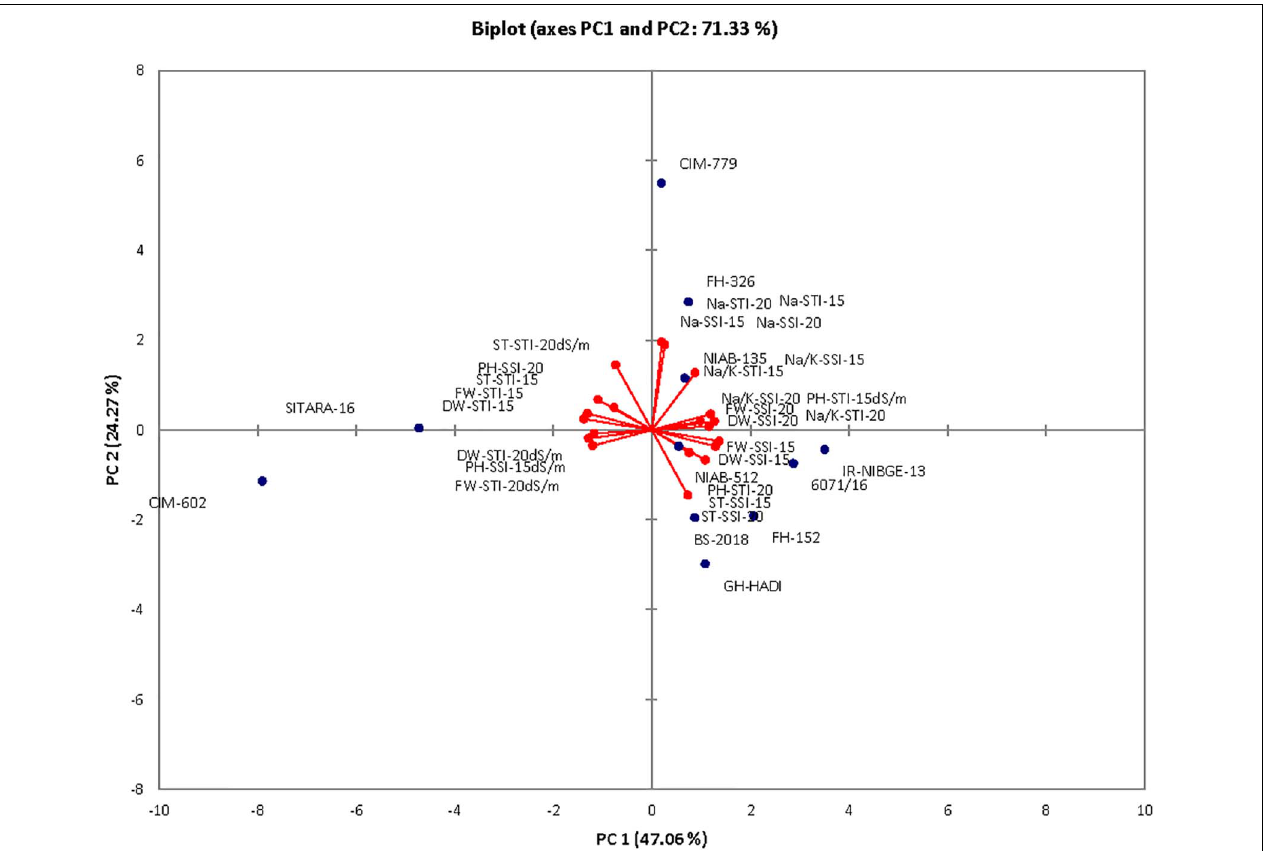
FIGURE 10 | Biplot illustration of all the genotypes under control and salt stress